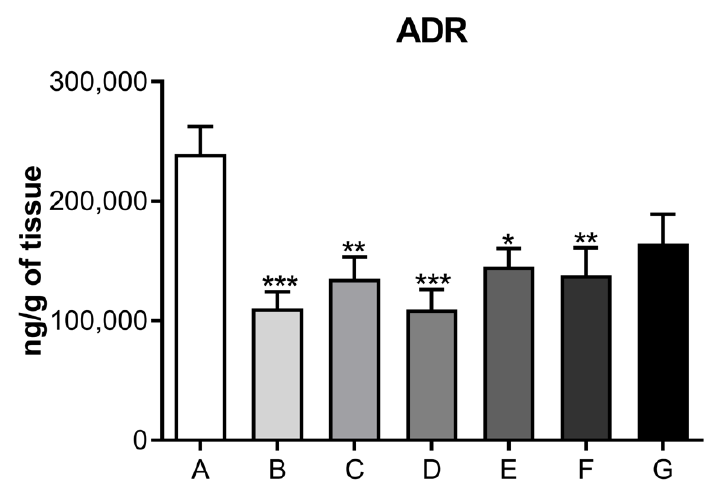
Figure 7. Level of neurotransmitters related to adrenaline in the cardiac muscle of dams submitted to the postpartum depression model, treated or not with different doses of ketamine intraperitoneally. The means and the respective standard errors are presented. N = 10. Animals per group * p < 0.05, ** p < 0.01 and *** p < 0.001 one-way ANOVA followed by Bonferroni test. A—control group (normal, not treated); B—control and treated with saline; C—depressed and treated with saline; D—depressed + ketamine 5 mg/kg; E—depressed + ketamine 10 mg/kg; F—depressed + ketamine 20 mg/kg; G—depressed + single dose of ketamine 10 mg/kg group.